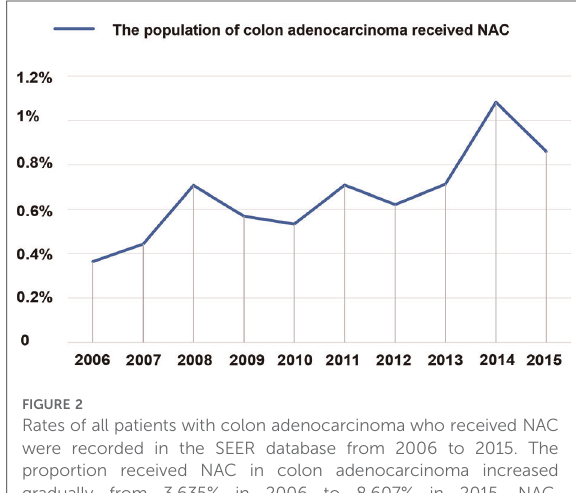
FIGURE 2 Rates of all patients with colon adenocarcinoma who received NAC were recorded in the SEER database from 2006 to 2015. The proportion received NAC in colon adenocarcinoma increased gradually from 3.635% in 2006 to 8.607% in 2015. NAC, neoadjuvant